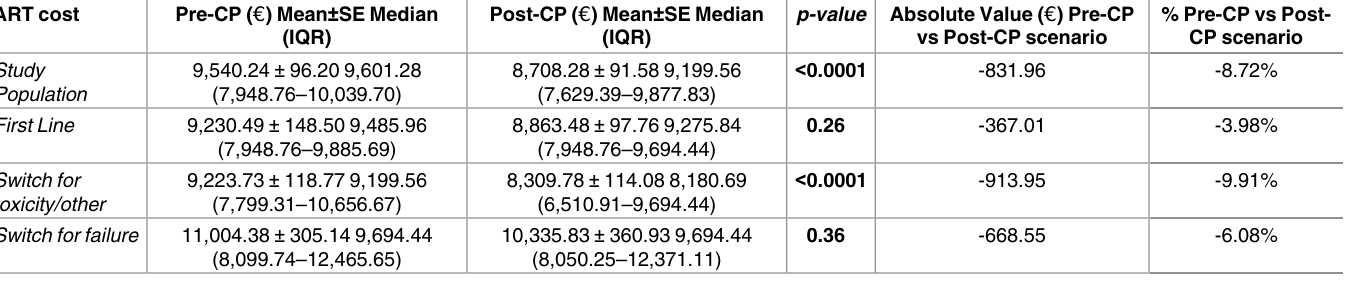
Table 6. Mean yearly per-patient ART costs, Lombardy Region, Italy, comparing Pre-CP (2009–2010) and Post-CP (2011–2012), related to 2014 price level. ART cost Pre-CP ( € ) Mean ± SE Median (IQR)